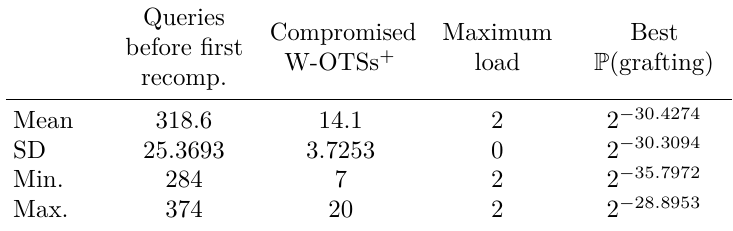
Table 17: Analysis of the universal forgery in N = 10 fault attacks at layer l ∗ = 7 against SPHINCS + -shake-256s-robust when 171 branches are cached. Queries before first